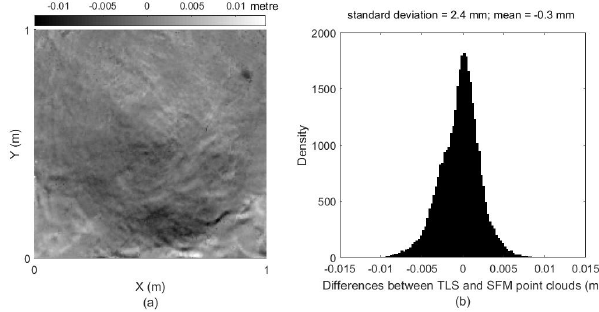
Figure 3. The accuracy of the SfM-derived point